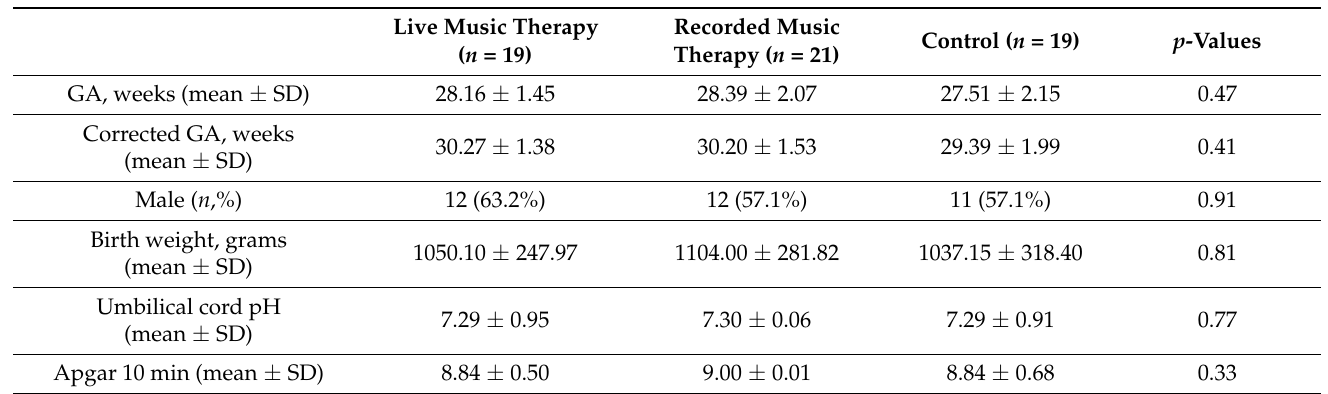
Table 1. Demographic characteristics of patients.